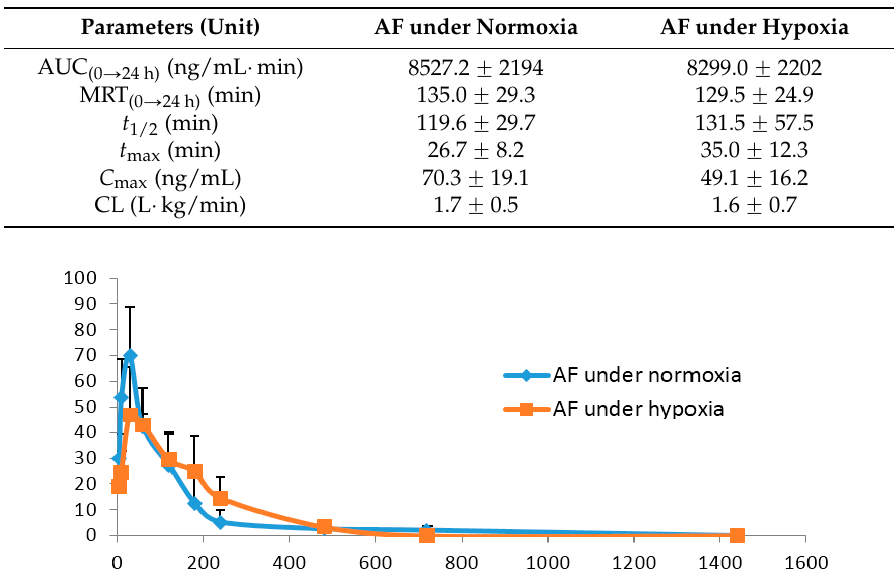
Figure 6. The mean plasma concentration–time profiles of albiflorin (AF) in rat under normoxia and hypoxia. The values are the mean ± SD, n = 6.